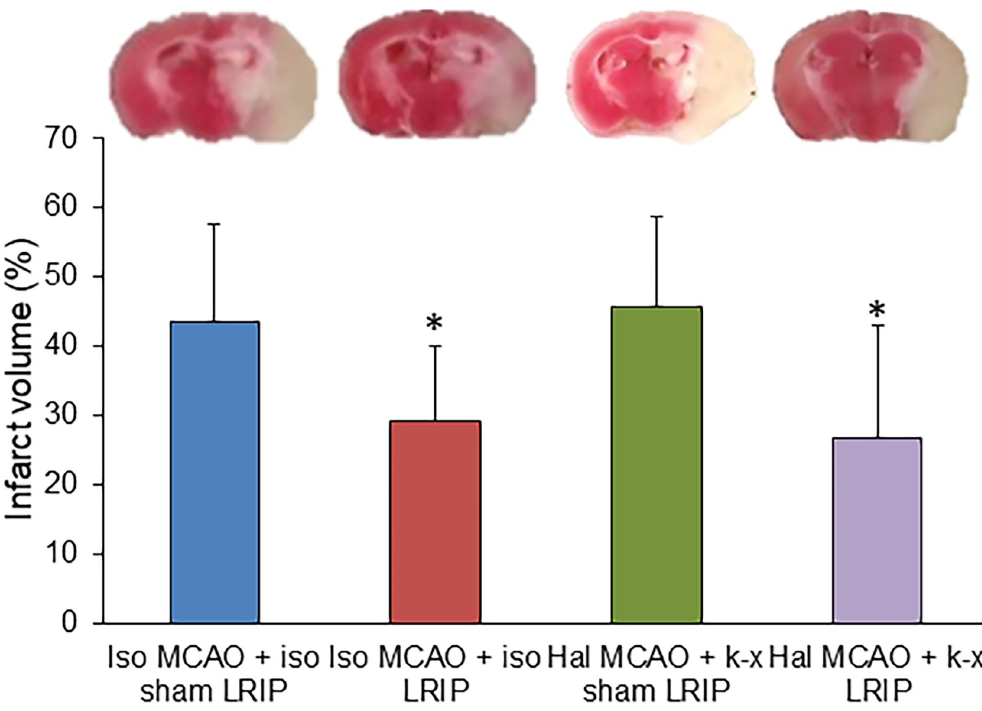
Fig 4. Effects of LRIP and anesthetic used on infarction volume after MCAO in mice. (A) The infarct area was observed by TTC staining of brain slices from each cohort. The viable tissue is stained red by TTC staining, but the infarcted area remains unstained, exhibiting pale yellow/white color. (B) Quantitative evaluation of percent infarction volume in different cohorts of mice was observed at 76 h after MCAO. The LRIP treatment group had significantly lower infarction volume compared with the sham group. The infarction volume was similar in cohort 2 and cohort 4, suggesting that the reduction in infarction volume was independent of the anesthetic used. Data are presented as mean ± SD. n = 6–11, � p < 0.05.